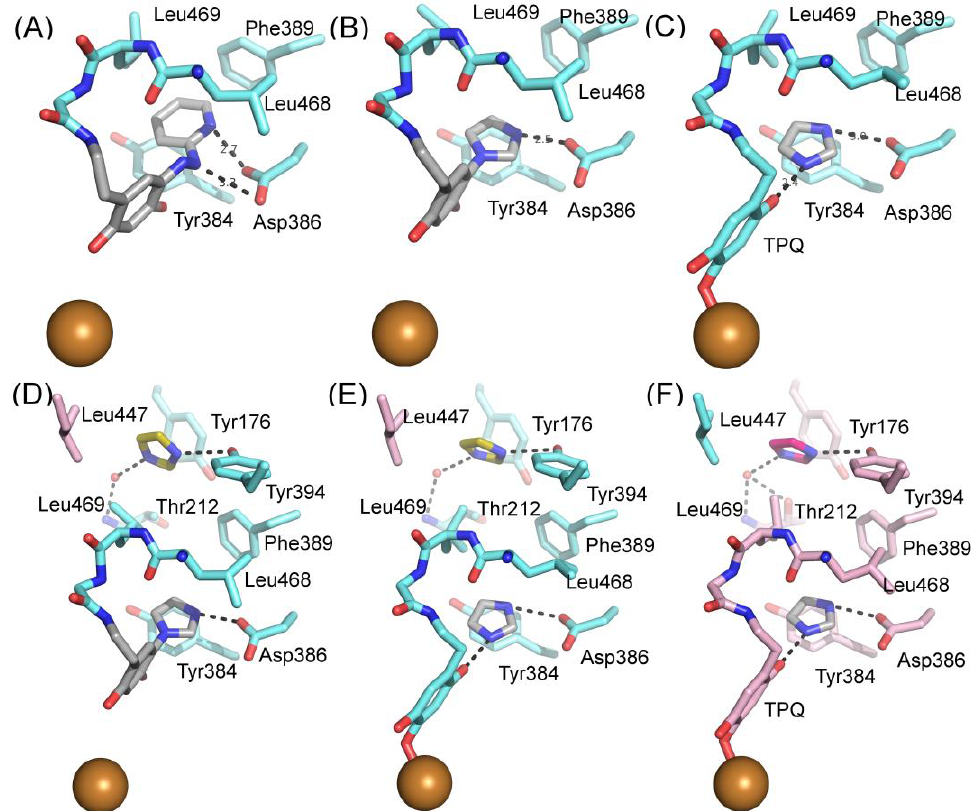
Figure 4. The binding modes of 2HP and imidazoles to hVAP-1. Chain A of the hVAP-1 dimer is shown in pink and chain B in cyan; ( A ) the covalent adduct of 2HP and TPQ (grey; PDB code 2C11); ( B ) the covalent adduct of imidazole and TPQ (grey; PDB code 2Y74); ( C ) the non-covalent complex of imidazole (PDB code 2Y73); ( D ) the binding site of the second imidazole (yellow) in the covalent imidazole complex (PDB code 2Y74); ( E ) the binding site of the second imidazole (yellow) in chain A of the non-covalent imidazole complex (PDB code 2Y73); ( F ) the di ff erent binding mode of the